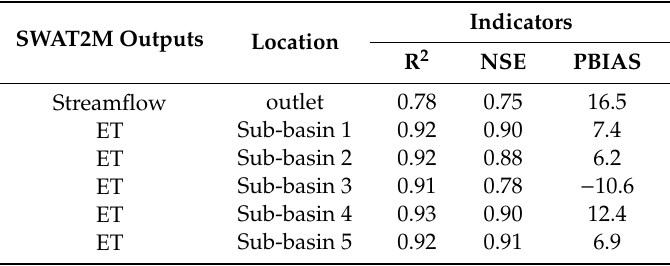
Table 4. Performance of the Soil and Water Assessment Tool (SWAT)-2M model to simulate the monthly streamflow and evapotranspiration (ET). NSE: Nash-Sutcli ff e ffi ciency; PBIAS: percent bias; R 2 : coe ffi cient of determination. SWAT2M